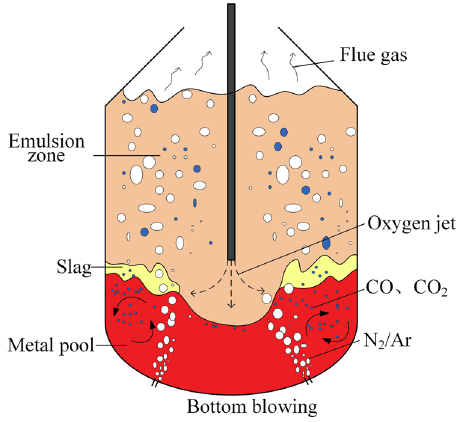
Figure 1: Schematic of BOF